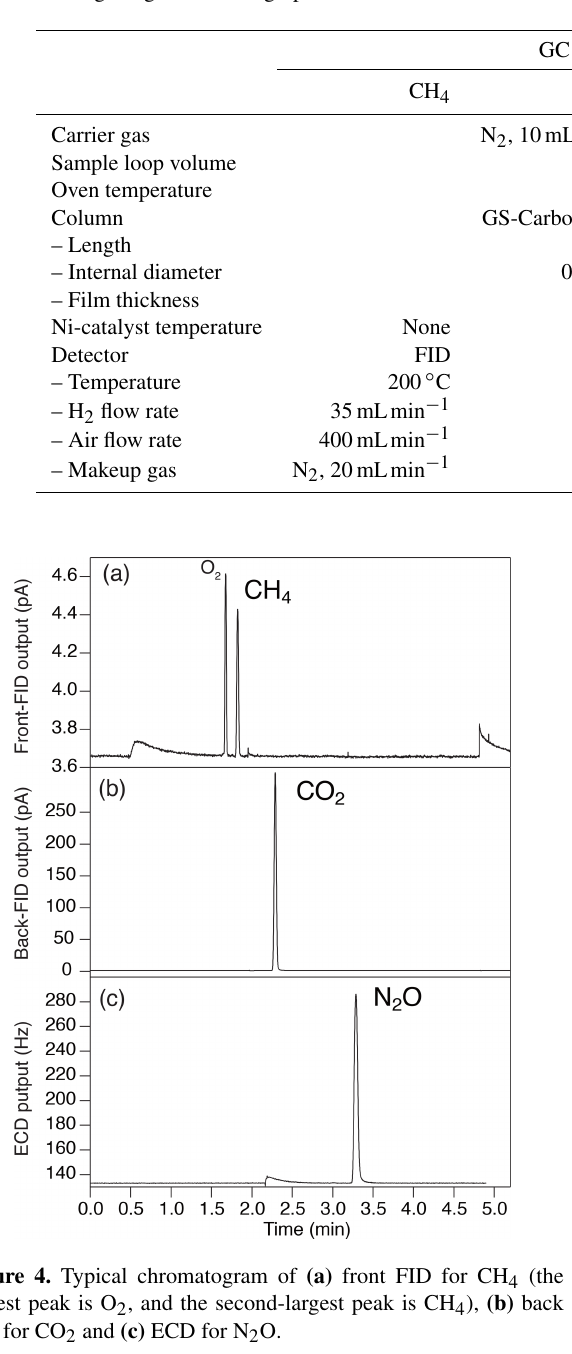
Table 1. Settings of gas chromatographs.